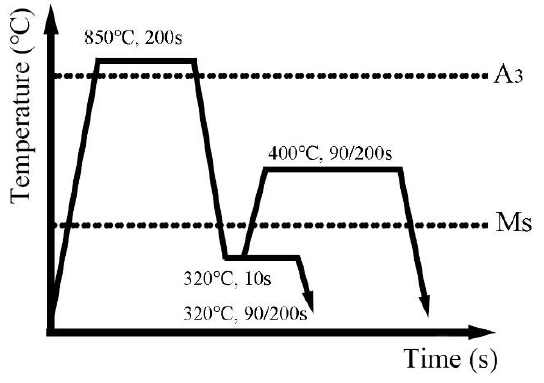
Figure 2. Heat-treatment cycle used in this